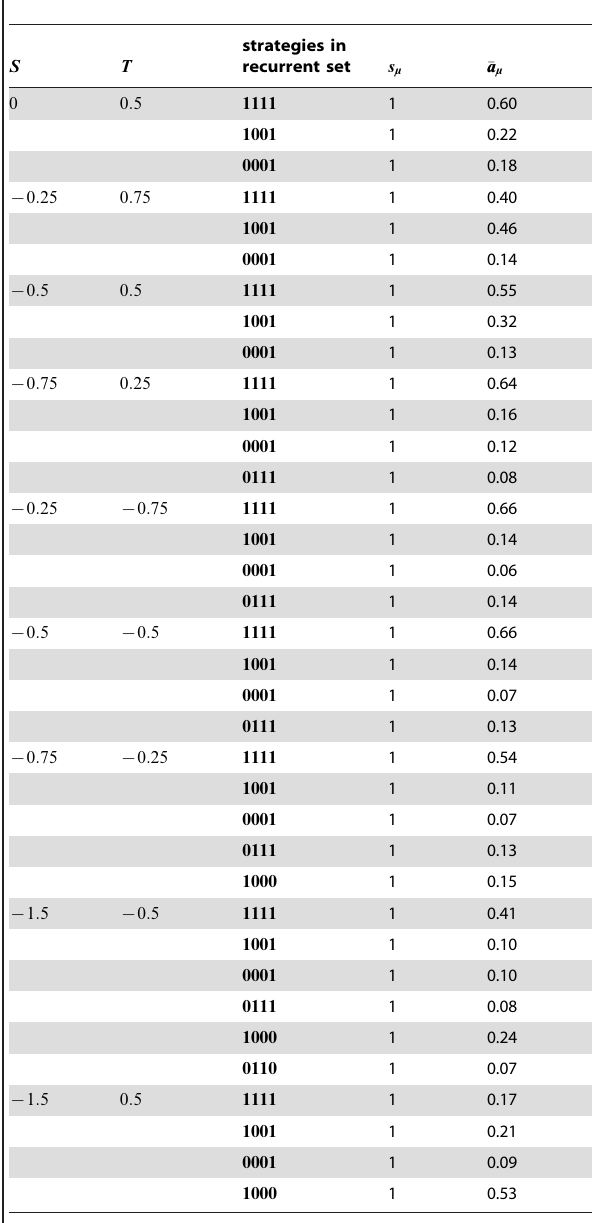
Same as Table 1 for the Stag Hunt game quadrant ( S ƒ 0 , T v 1 ).